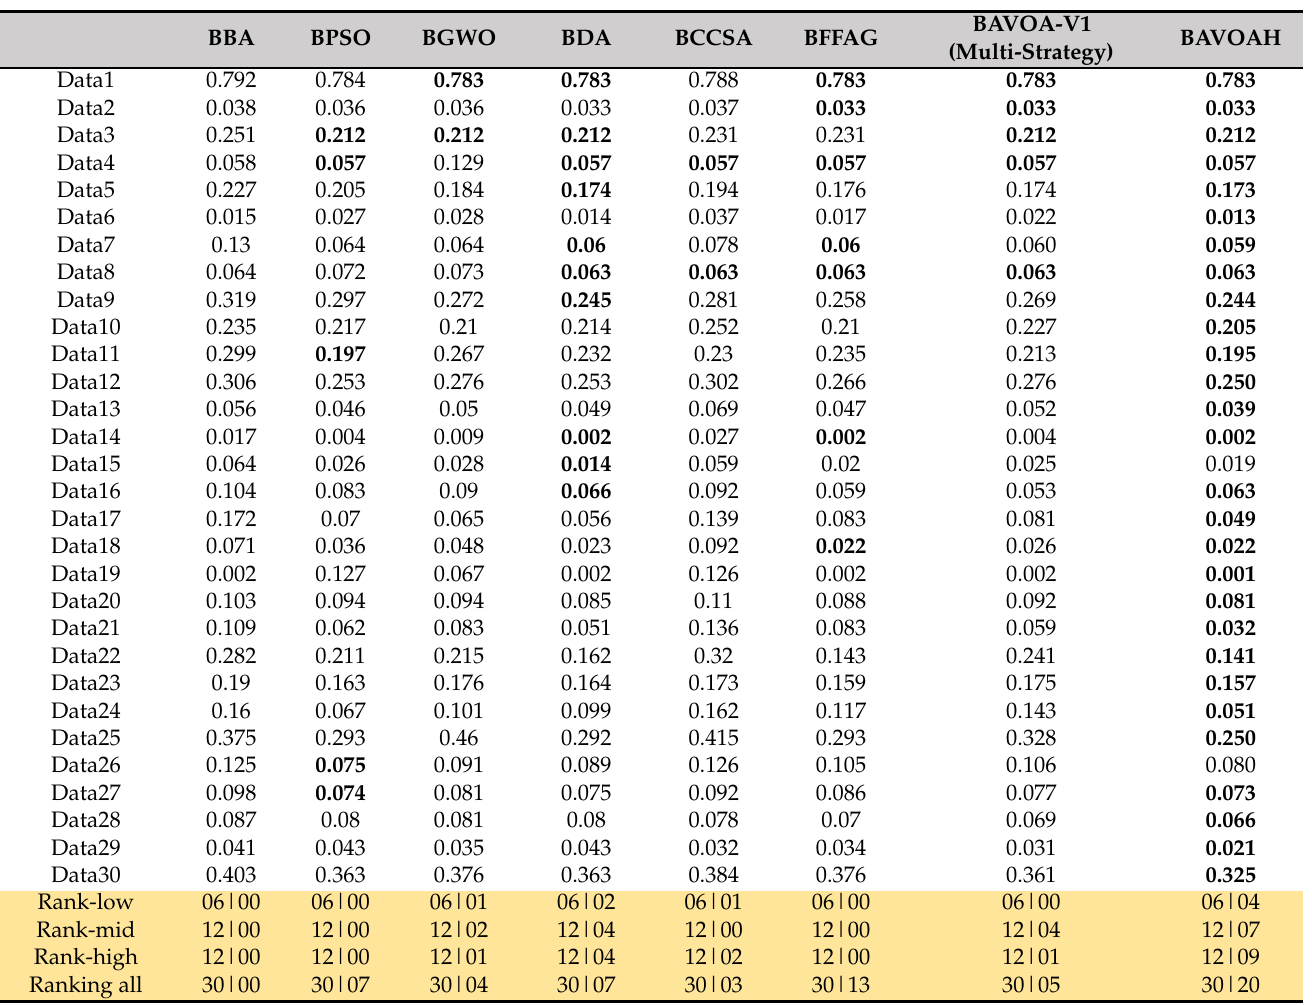
Table 8. Comparison of the proposed BAOVAH (hyper-heuristic) and BAVOA-V1 (multi-strategy) an approach based on the criterion of the best value of the fitness